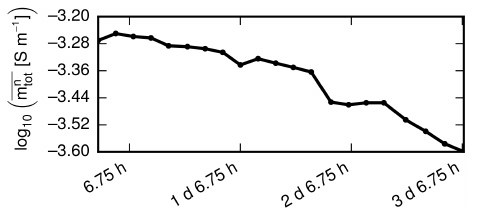
Figure 11. Mean value of DD-derived total chargeability m n tot plot- ted vs. time after start of the experiment. Average values were com- puted based on all pixels belonging to the root system zone. Figure 12. Spatial distribution of the DD-derived parameter, τ